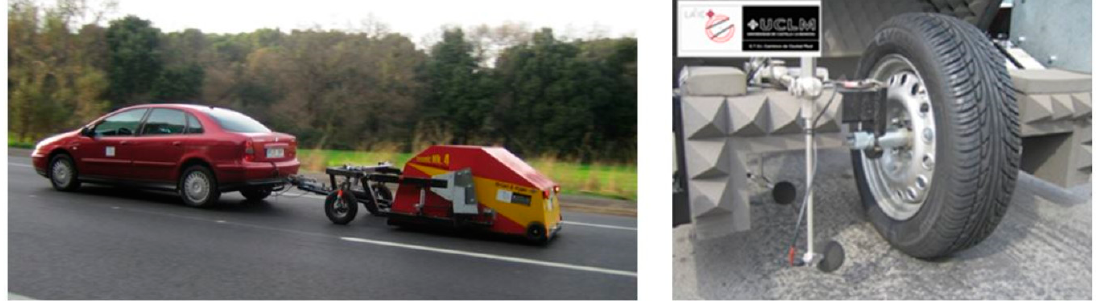
Figure 3. Tiresonic Mk4-LA2IC for acoustics characterization of road surfaces and detail of the microphone positions.